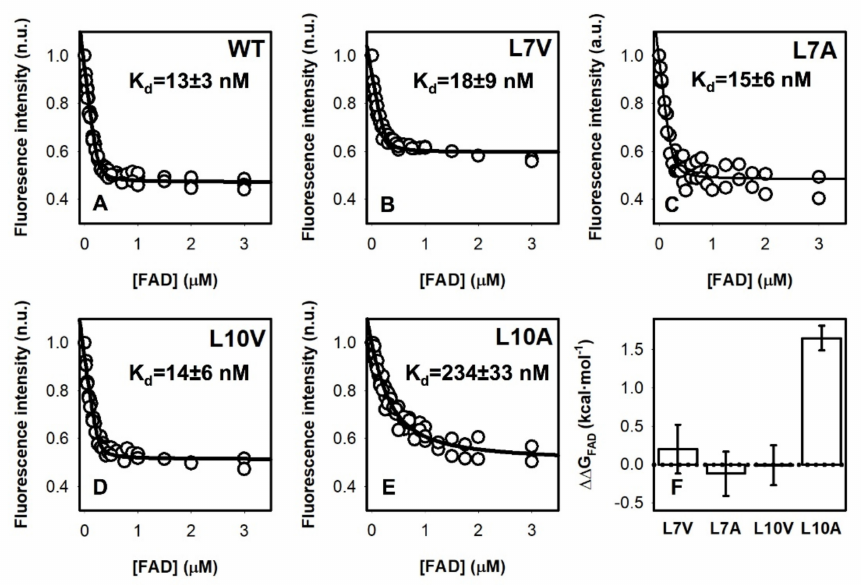
Figure 3. FAD content of purified NQO1 variants upon purification using IMAC plus SEC. ( A ) Absorption spectra in the region of absorption of FAD; ( B ) FAD content was calculated us- ing the ratio of absorbance at 280 and 450 nm as described in materials and methods. Data are the average from two different purifications.